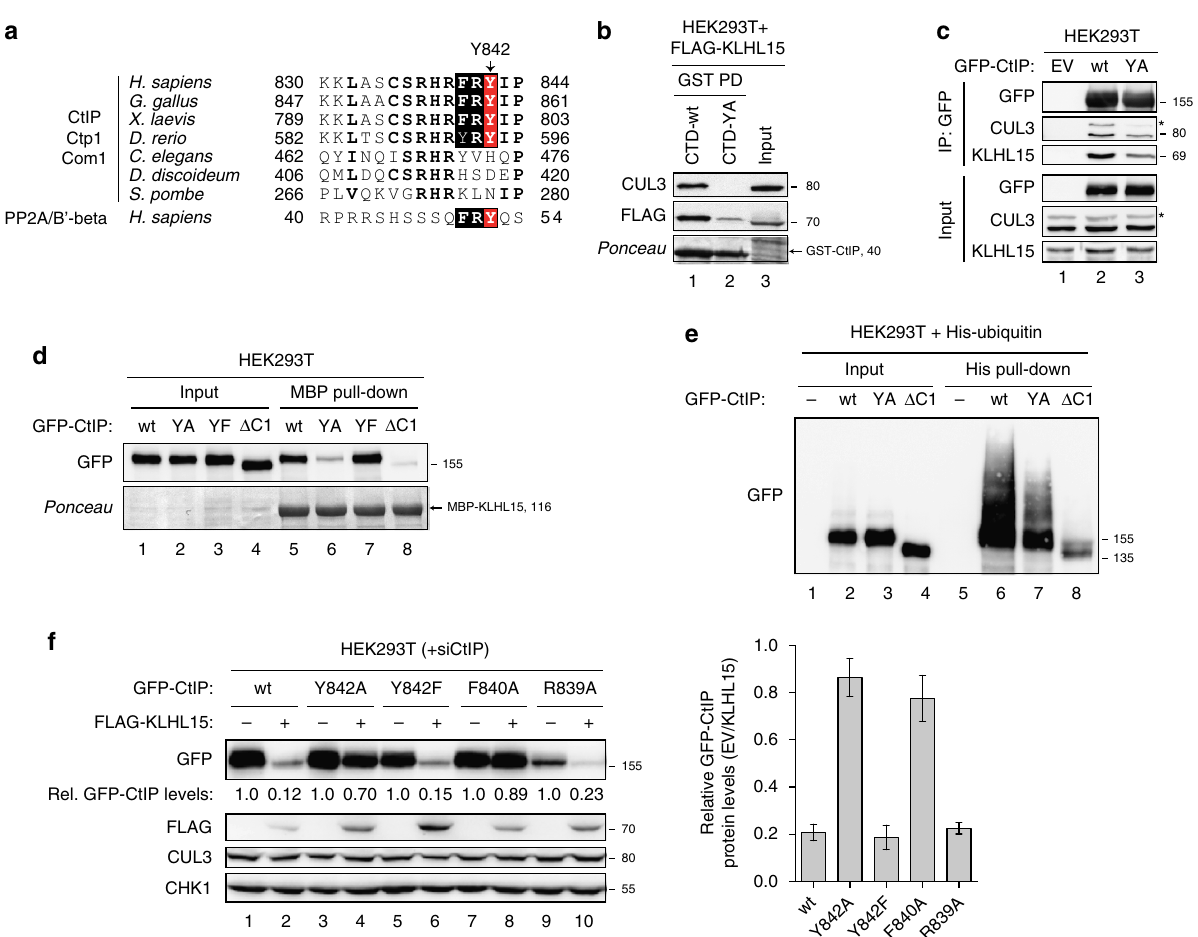
Figure 6 | Identification of a conserved FRYmotif in vertebrate CtIP essential for KLHL15 interaction. ( a ) Alignment of the KLHL15-interacting region in human CtIP (aa 830–844) with the corresponding region in CtIP/Ctp1/Com1 orthologs of other species. A part of the KLHL15 binding domain in human PP2A/B’-beta is shown below 44 . The rectangular box represents the putative KLHL15-binding motif (FRY). The highly conserved tyrosine residue (Y842 in human CtIP) is highlighted in red. Other, highly conserved amino acid residues are marked in bold typeface. ( b ) Bacterially expressed GST fusion proteins of the CtIP CTD (aa 790–897), either wt or Y842A mutant, were coupled to glutathione sepharose beads and incubated with lysates from HEK293T cells transfected with the FLAG-KLHL15 expression plasmid for 48h. Pulled-down protein complexes and the input were analysed by immunoblotting. ( c ) HEK293T cells were transfected with either empty vector (EV) or the GFP-CtIP expression constructs. 48h after transfection, cells were lysed and whole-cell extracts were subjected to IP using anti-GFP affinity resin. Inputs and recovered protein complexes were analysed by immunoblotting. ( d ) Recombinant MBP-KLHL15 was coupled to amylose beads and incubated with lysates from HEK293T cells transfected with the indicated GFP-CtIP expression constructs for 48h. Inputs and pulled-down protein complexes were analysed by immunoblotting. ( e ) HEK293Tcells were cotransfected with the indicated GFP-CtIP constructs and His-Ubiquitin. Twenty-four hours post transfection cells were treated with MG-132 (20 m M) for 4h. Cells were then lysed in buffer containing guanidium-HCl and ubiquitin conjugates were pulled-down using Ni-NTA-agarose beads, eluted and analysed by immunoblotting with anti-GFP antibody. ( f ) HEK293T cells were transfected with CtIP siRNA and 24h later cotransfected with the indicated siRNA-resistant GFP-CtIP expression constructs and FLAG-KLHL15. Forty-eight hours post siRNA transfection cells were analysed by immunoblotting (left). The GFP-CtIP signal intensities were quantified using ImageJ and represented as EV/FLAG-KLHL15 ratios (right). Data are represented as mean values of